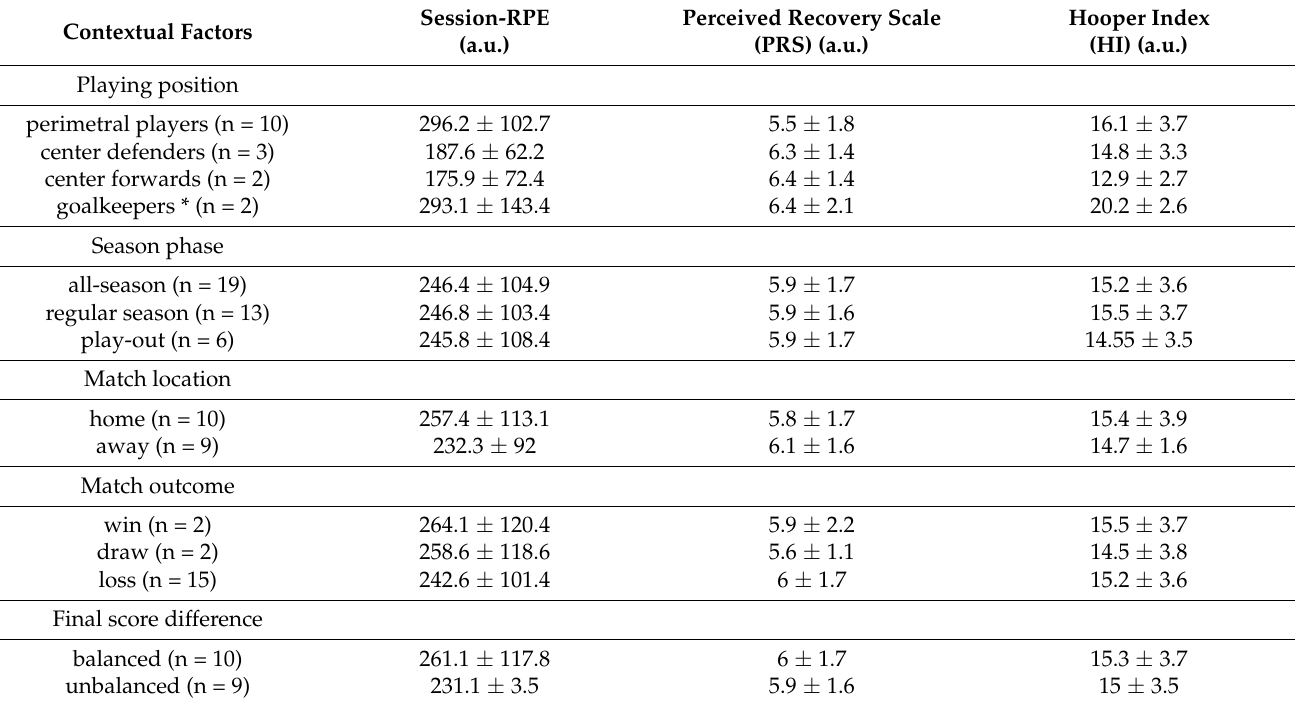
Table 2. Descriptive data (mean ± SD) of the contextual